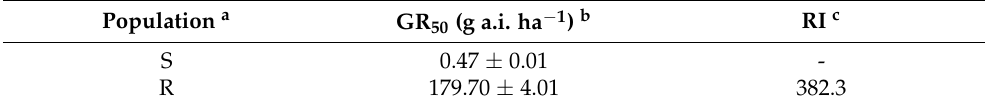
Table 1. GR 50 values of S and R populations of Silene conoidea treated with tribenuron-methyl. Each value represents the mean (SE) of two experiments, each containing three replicates. RI was calculated as the ratio of GR 50 values from resistant and susceptible